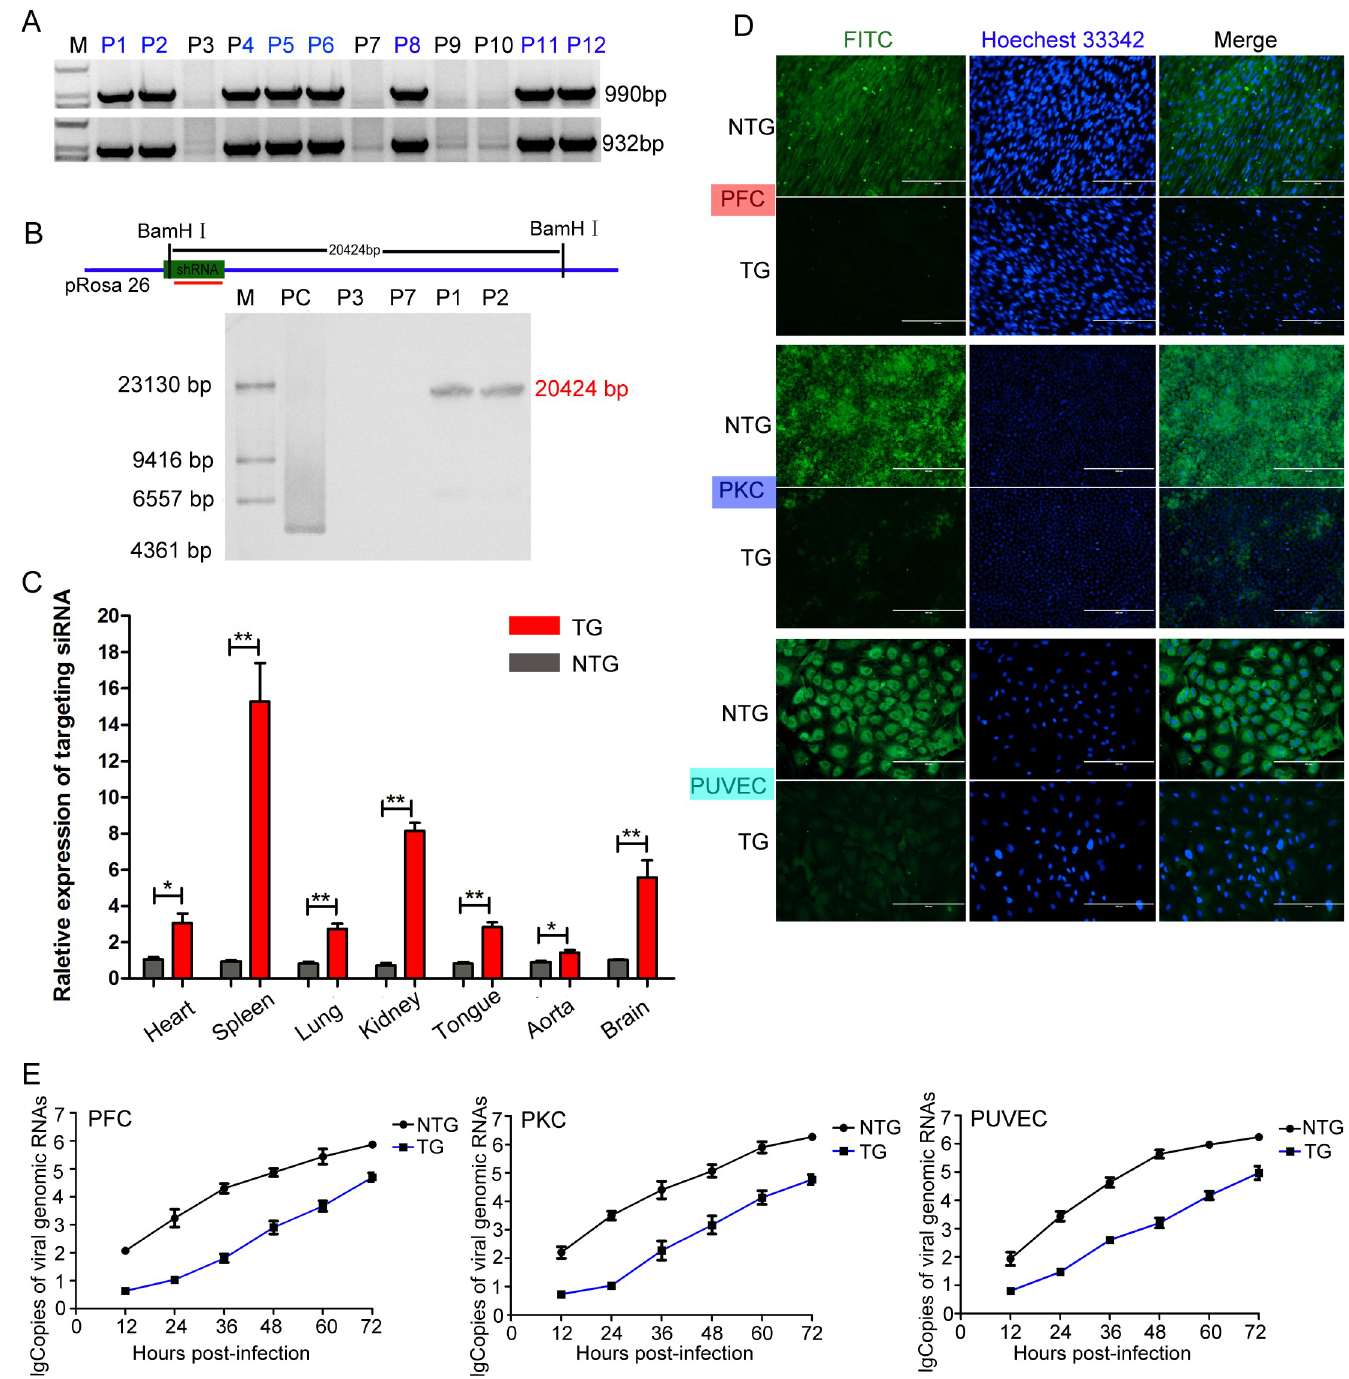
Fig 2. Generation of F0-generation TG pigs expressing the targeting siRNA. (A ) Genomic PCR analysis of the F0-generation to identify TG pigs. P1, P2, P4, P5, P6, P8, P11 and P12 indicate TG pigs, and P3, P7, P9 and P10 indicate NTG pigs. M: D2000. ( B ) Schematic for Southern blotting. The hybridization signals indicated that the shRNA gene was successfully integrated into the p Rosa26 locus in the TG pigs. M: DNA maker. PC: positive control plasmid. P3 and P7 indicate NTG pigs, and P1 and P2 indicate TG pigs. ( C ) The relative expression levels of the targeting siRNA in various tissues and organs from TG pigs were determined by qPCR. The expression levels were analysed using the unpaired t-test ( � p < 0.05; �� p < 0.01). Error bars represent the SEM, n = 3. TG: transgenic pigs. NTG: wild-type pigs. ( D ) Virus resistance in three types of isolated primary cells from TG and NTG pigs was examined by IFA. The cells cultured in 24-well plates were inoculated with 200 TCID 50 of CSFV (Shimen strain). At 72 hours post infection, the CSFV-infected cells were incubated with an E2-specific antibody (PAb) and then stained with fluorescein isothiocyanate (FITC)-labelled goat anti-pig IgG (1:100). Cells were analysed under fluorescence microscope. PFC: porcine fibroblast cells. PUVEC: porcine umbilical